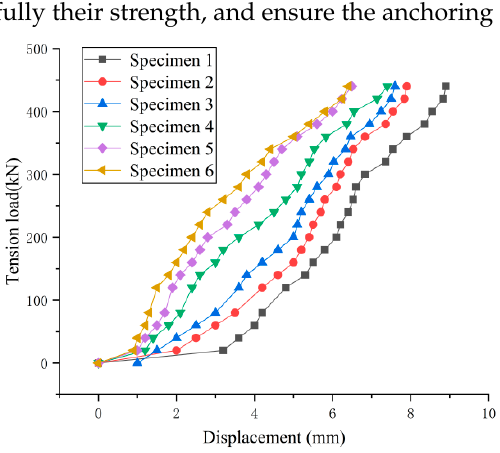
Figure 13. Force ‐ displacement curves. Figure 13. Force-displacement curves.